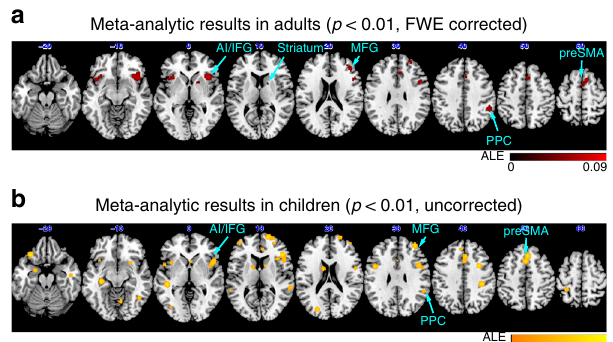
Fig. 2 Meta-analysis of neuroimaging studies in adults and children. a ALE Meta-analysis of 70 inhibitory control neuroimaging studies in adults (34 SST, 36 GNGT) revealed consistent activation of bilateral anterior insula (AI), right inferior frontal gyrus (IFG), middle frontal gyrus (MFG), pre- supplementary motor area (preSMA), posterior parietal cortex (PPC) and striatum ( p < 0.01, FWE corrected). b ALE Meta-analysis in 14 studies in children (2 SST, 12 Go/NoGo) revealed activation of AI, IFC, MFG, preSMA and PPC but only at a weaker threshold ( p < 0.01, uncorrected). Weak meta-analytic results in children re fl ect inconsistent and/or weak fi ndings inform previous neuroimaging studies of inhibitory control in children.